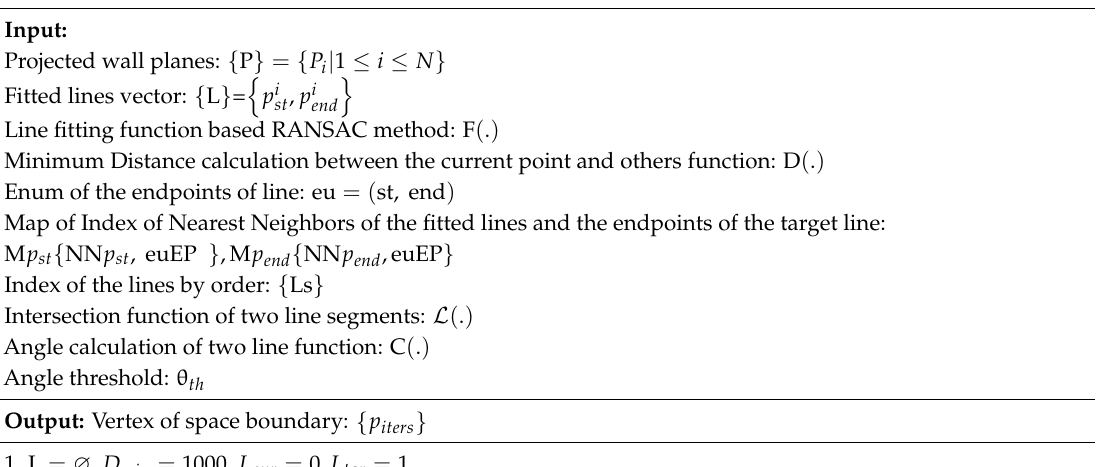
Algorithm 2: Boundary generation